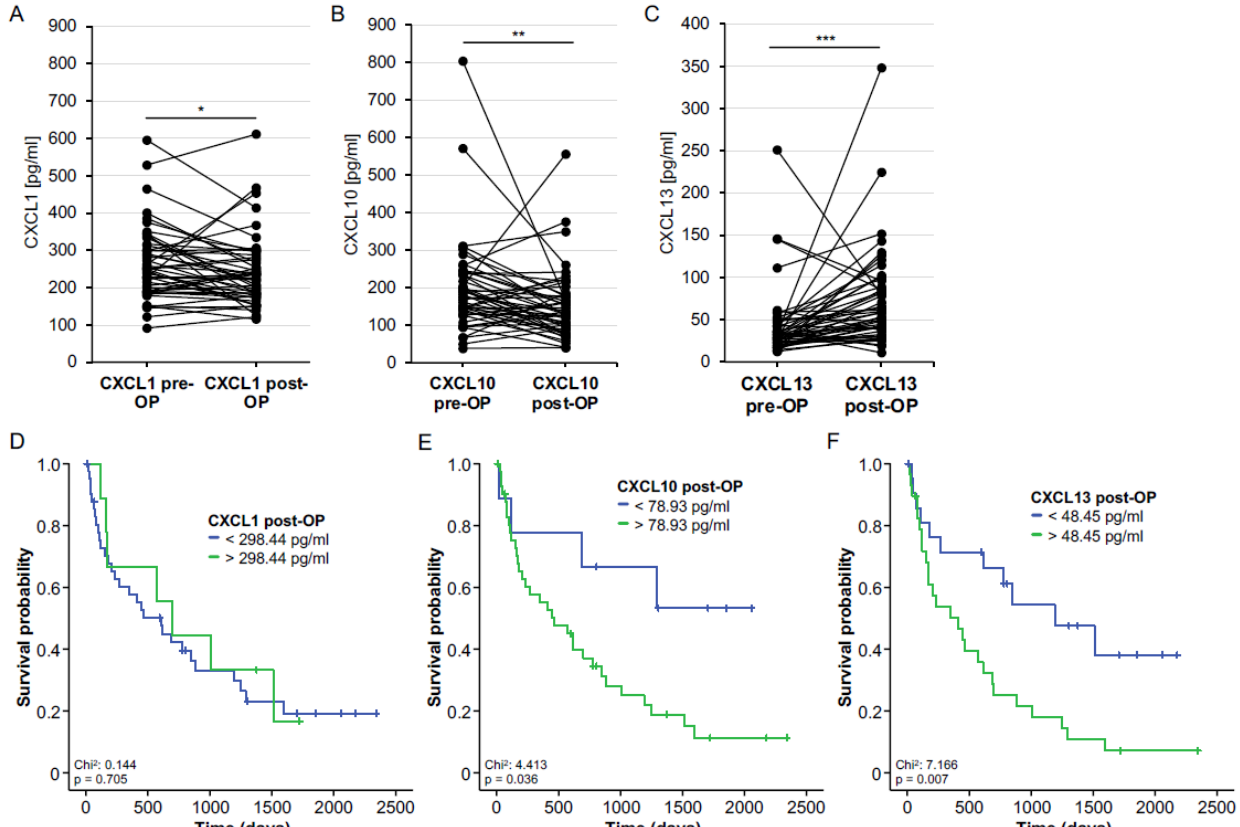
Figure 3. Postoperative chemokine levels and outcomes. ( A ) Serum levels of CXCL1 were significantly lower after BTC resection. ( B ) Serum levels of CXCL10 were significantly lower after BTC resection. ( C ) Serum levels of CXCL13 were significantly higher after BTC resection. ( D – F ) Overall survival in BTC patients with postoperative CXCL1, CXCL10 and CXCL13 levels above or below the ideal prognostic cut-off values. * p < 0.05; ** p < 0.01; *** p < 0.001.